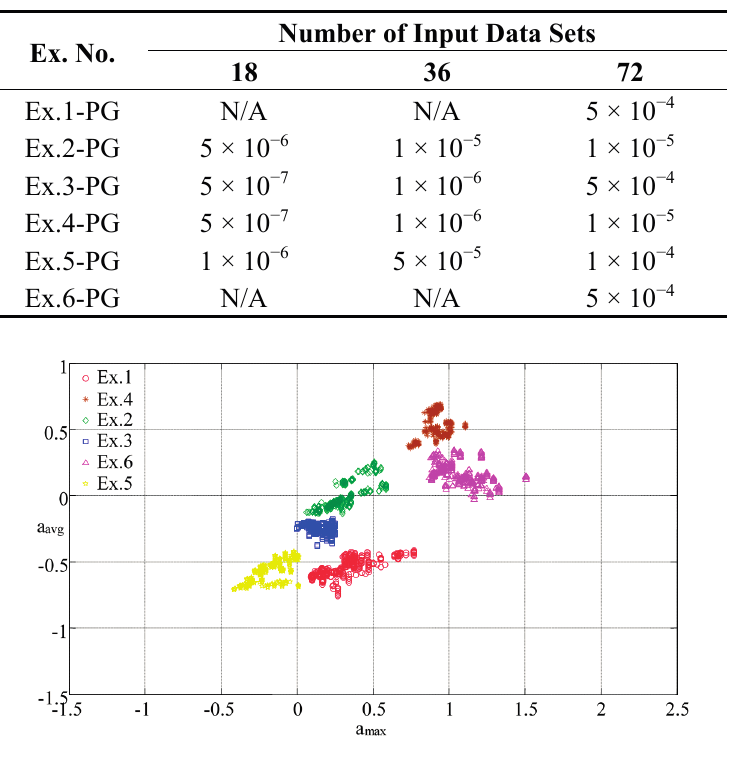
Figure 8. Feature distribution in characteristic space of accelerations of all exercises in z